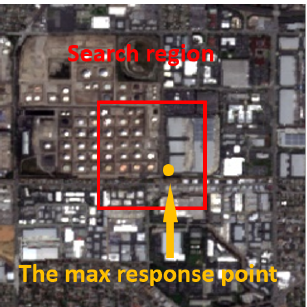
Figure 5. The max Harris response in the search region.